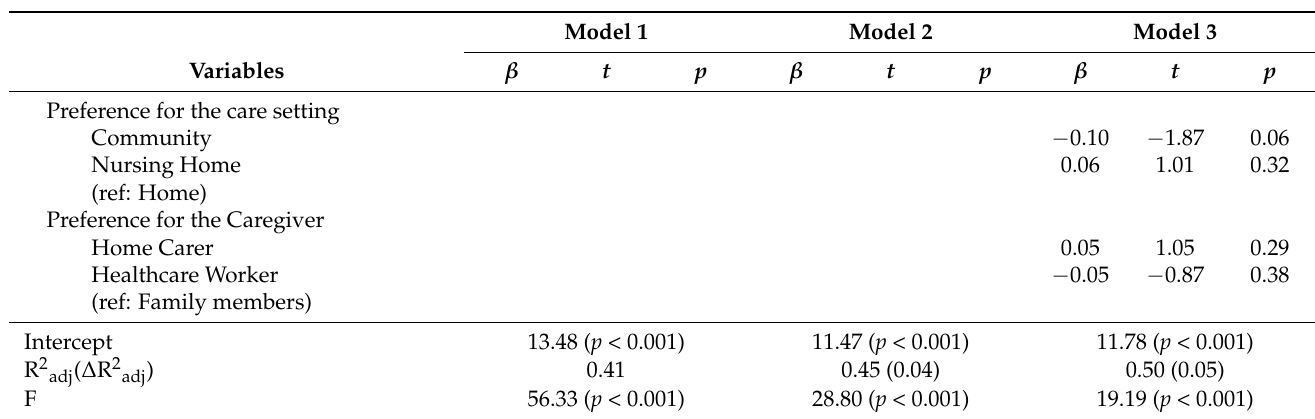
Table 4. Cont. Model 1 Model 2 Model 3